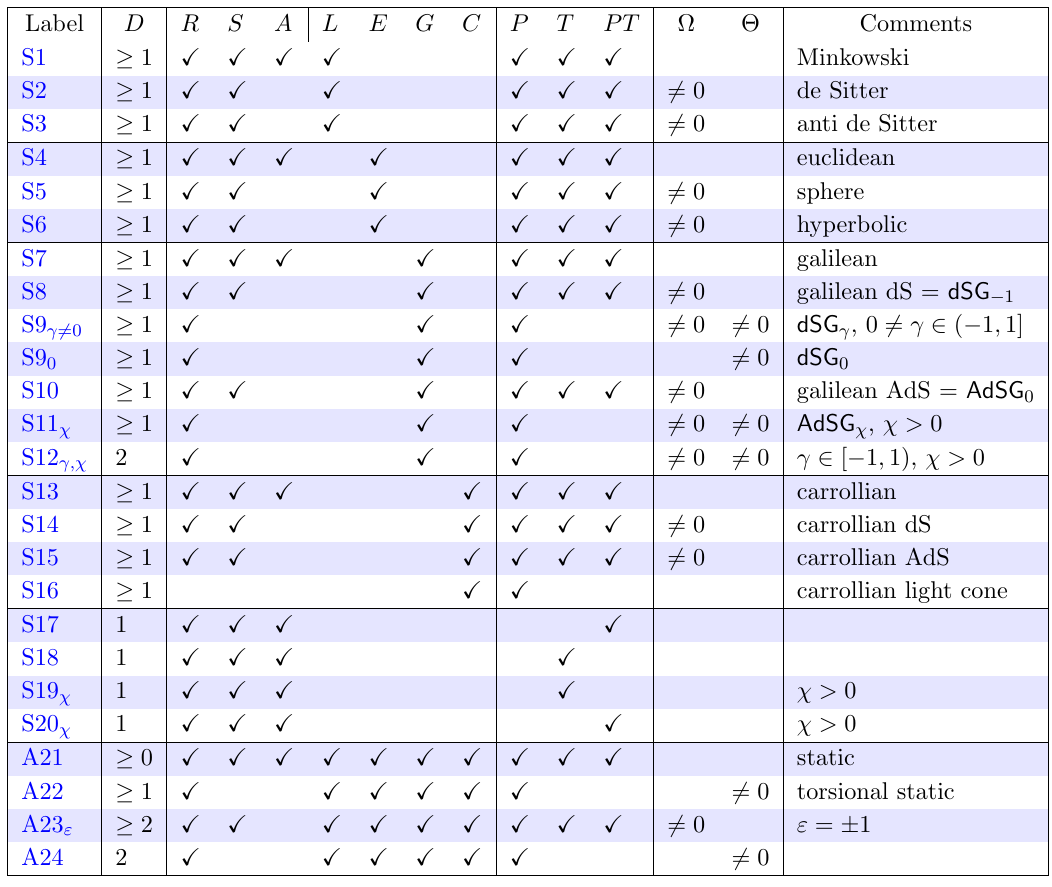
Table 16 . Properties of simply-connected homogeneous spacetimes. This table describes if a spacetime of dimension D + 1 is reductive (R), symmetric (S) or a(cid:14)ne (A). A spacetime might exhibit a lorentzian (L), riemannian (E), galilean (G) or carrollian (C) structure, and be invariant under parity (P), time reversal (T) or their combination (PT). Furthermore the canonical connection might be have curvature ((cid:10)) and/or torsion ((cid:2)). For the precise de(cid:12)nitions of these properties see sections 6.1 and